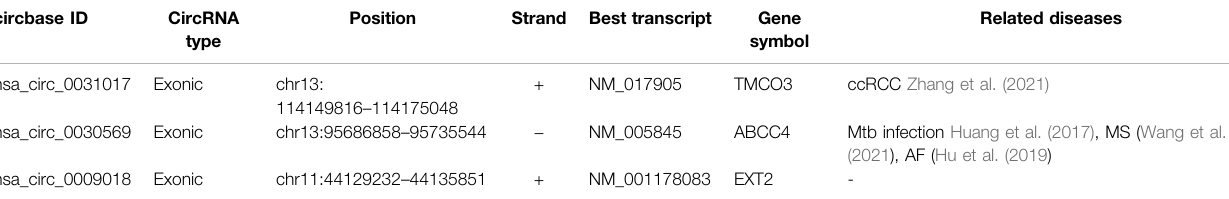
TABLE 3 | Basic characteristics and related diseases of three circRNAs identi fi ed by PCR. circbase